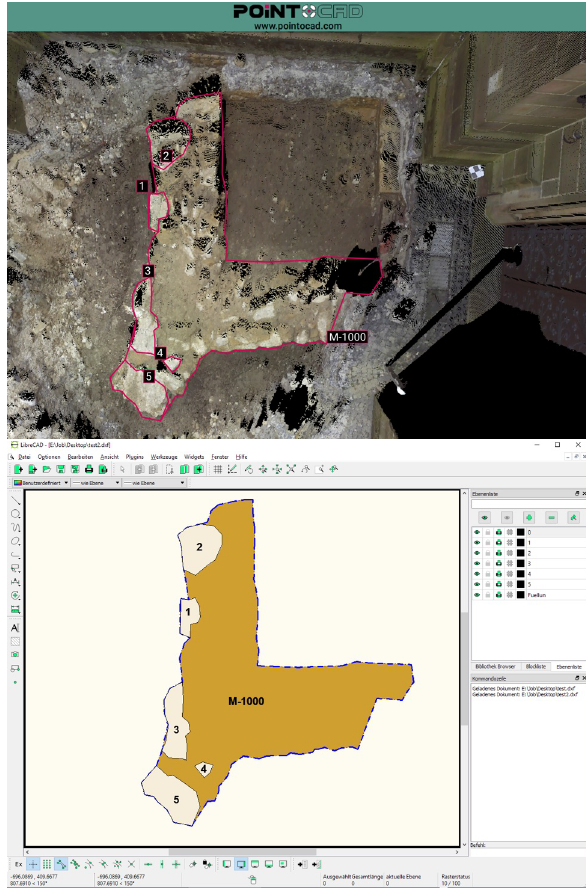
Figure 4 . Top: Representation of drawings on point clouds. Bot- tom: Representation of same drawings as an exported DXF file in a CAD